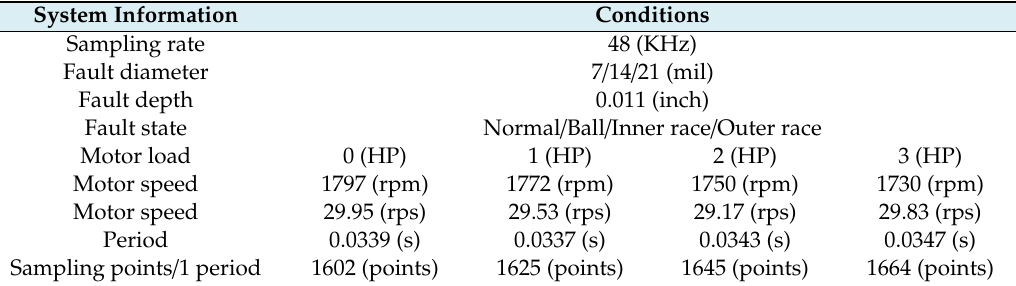
Table 1. Bearing fault state classification.